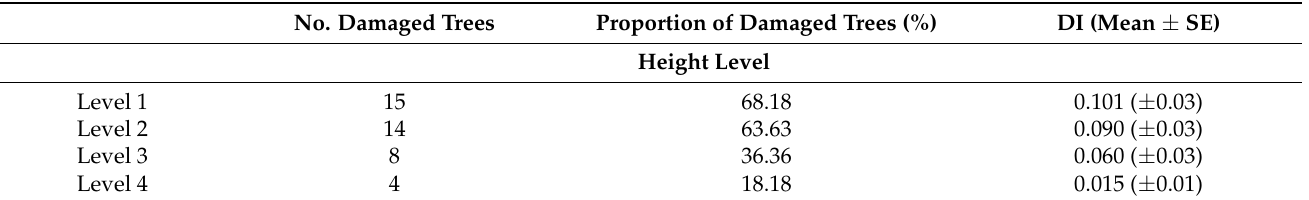
Table 7. Number of damaged trees by R. grassei and their proportion according to the four damaged levels and the four orientations separately. DI = Tree Damage Intensity. SE = standard